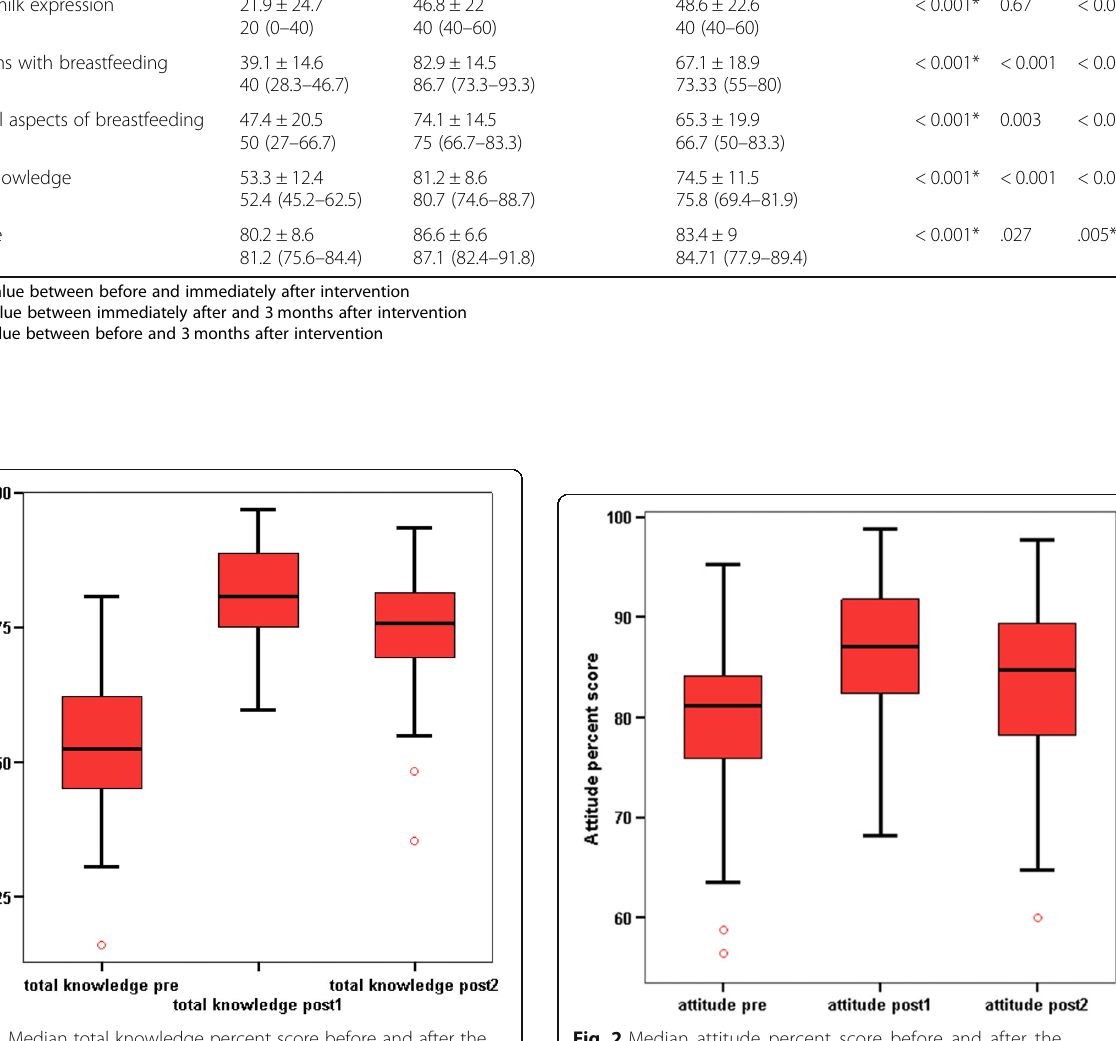
Fig. 2 Median attitude percent score before and after the education